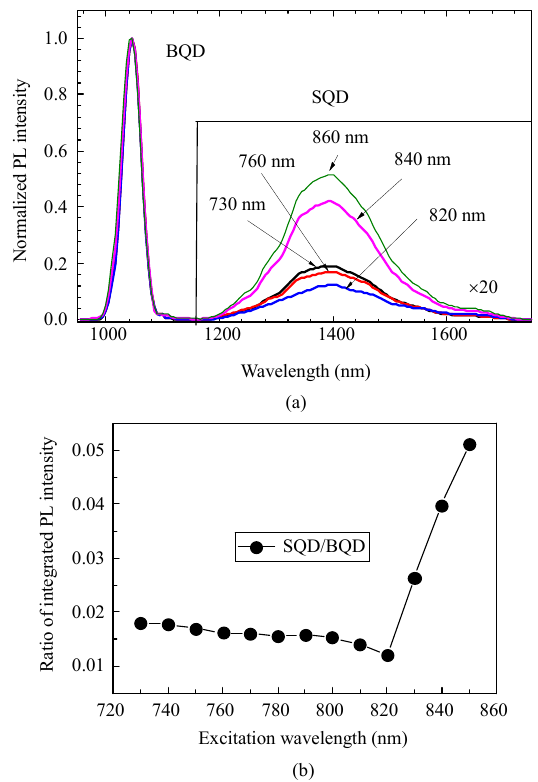
Fig. 4 PL spectra of BQDs and SQDs with different excitation laser wavelengths: (a) PL spectra at 77K and (b) integrated PL intensity ratio of SQDs to BQDs as a function of different excitation laser